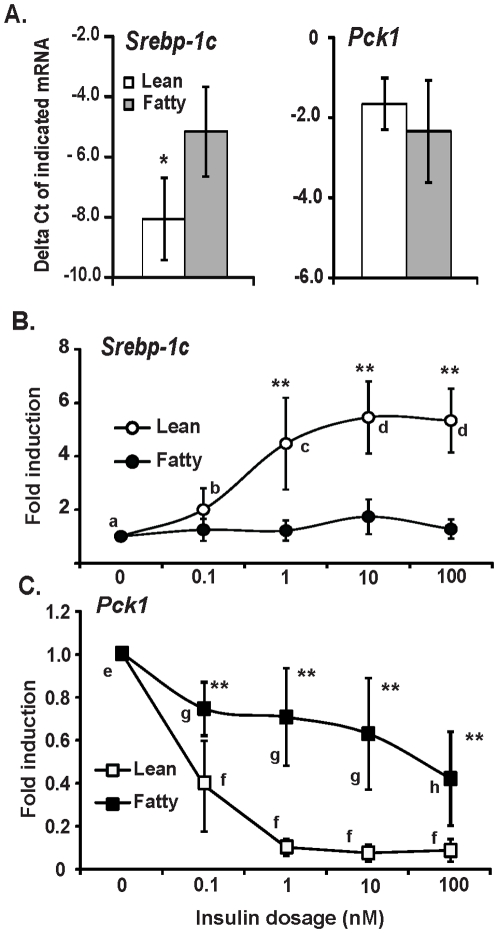
The maintenance of Srebp-1c and Pck1 mRNA expression patterns in primary hepatocyte culture (A), and the responses of Srebp-1c (B) and Pck1 (C) expression to insulin in cultured hepatocytes from ad libitum Zucker lean or fatty rats.Primary hepatocytes were isolated and pre-treated as described in Materials and Methods before they were incubated in medium A without or with increasing concentrations of insulin (0.01 to 100 nM) for 6 hours. Total RNA was extracted and subjected to real-time PCR analysis. A. The expression levels of Srebp-1c and Pck1 in control hepatocytes were expressed as −ΔCt. B and C. The expression levels of Srebp-1c (B) and Pck1 (C) in hepatocytes treated with vehicle control was arbitrarily assigned a value of one for its corresponding cell type. Results were plotted as fold induction and presented as means ± SD of five independent hepatocyte isolations for both lean and fatty rats (n = 5 for hepatocyte isolations; * for comparing the −ΔCt values of lean hepatocytes with fatty hepatocytes using independent-samples t test; ** for comparing fold induction values of the indicated transcripts in lean hepatocytes with that in fatty hepatocytes at indicated insulin concentrations using independent-samples t test; for Srebp-1c, c>b/a, d>a, using one-way ANOVA; for Pck1, e>f, e>h, using one-way ANOVA; all P<0.05,).